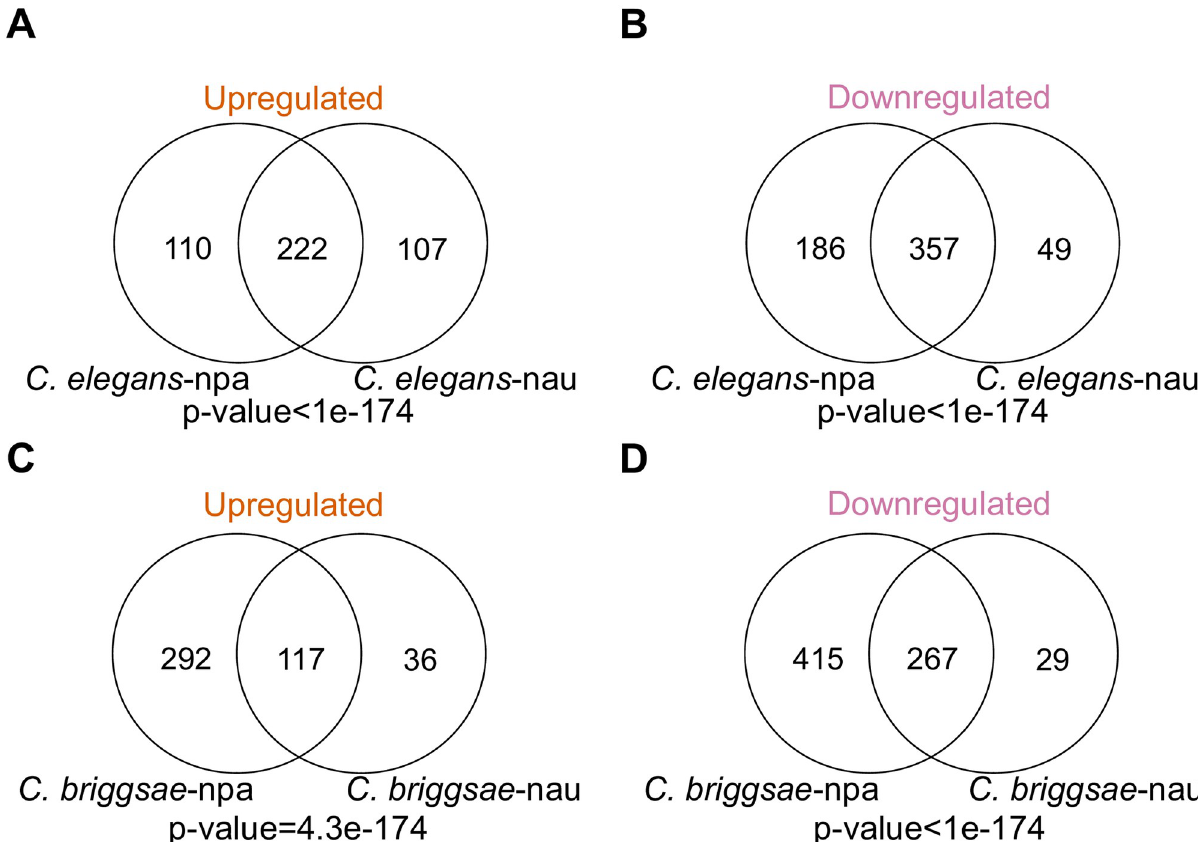
Fig 5. Transcriptional responses of Caenorhabditis hosts to Nematocida infection. (A-D) Venn diagrams of genes in C . elegans (A-B) or C . briggsae (C-D) that are upregulated (A and C) or downregulated (B and D) when infected by N . parisii or N . ausubeli . npa ( N . parisii) and nau ( N . ausubeli ).